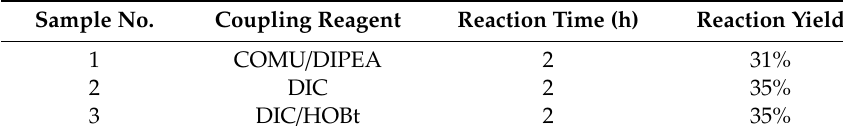
Table 1. Coupling reagents used for reaction with iodoacetic acid.